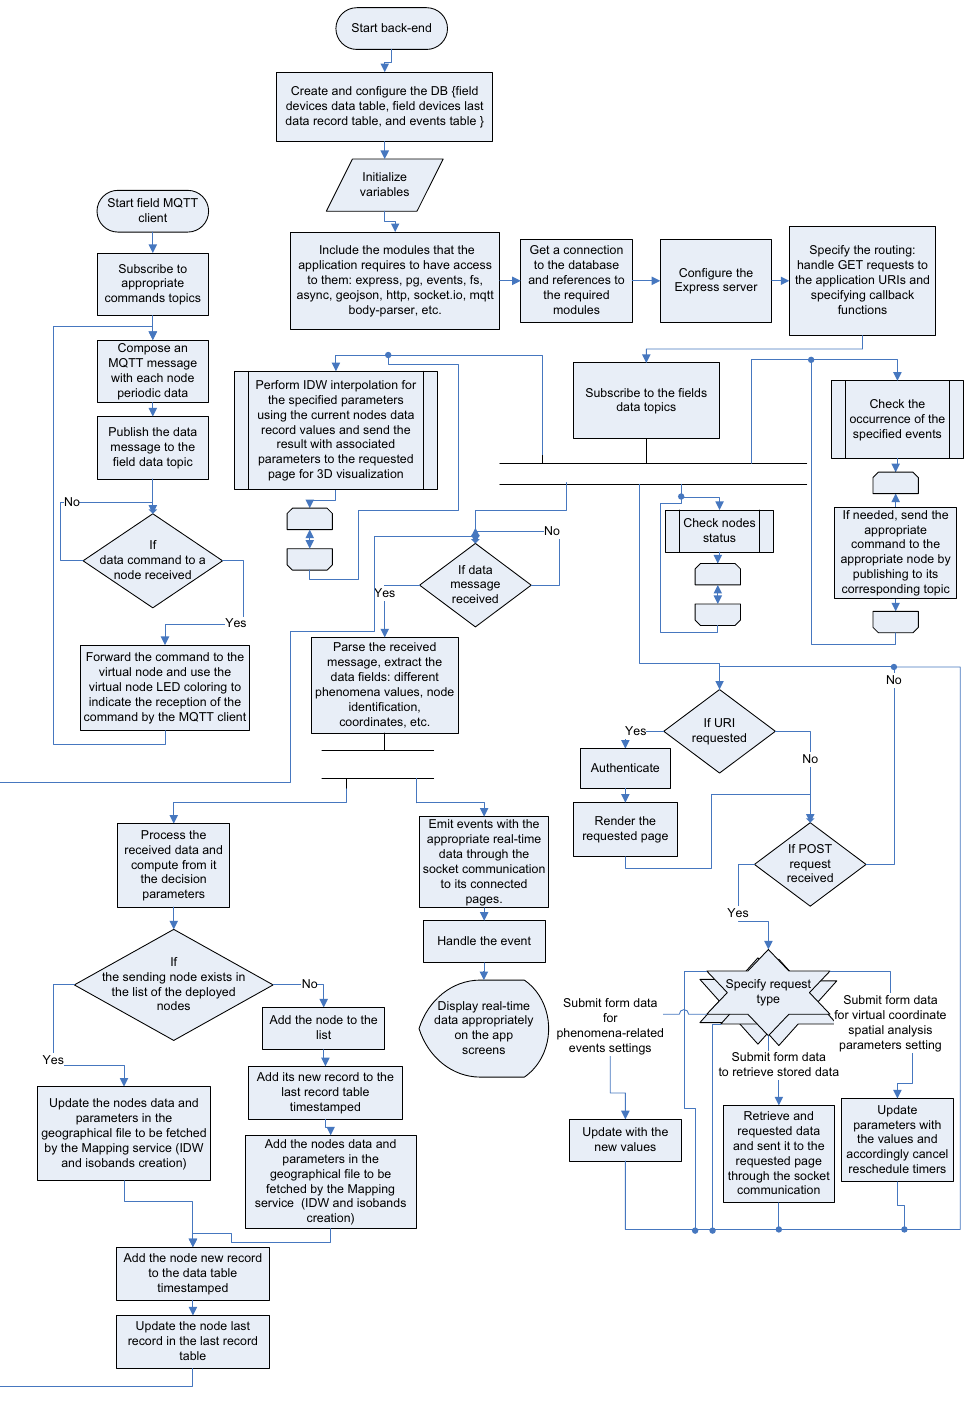
Figure 5. Heuristic diagram of the system main